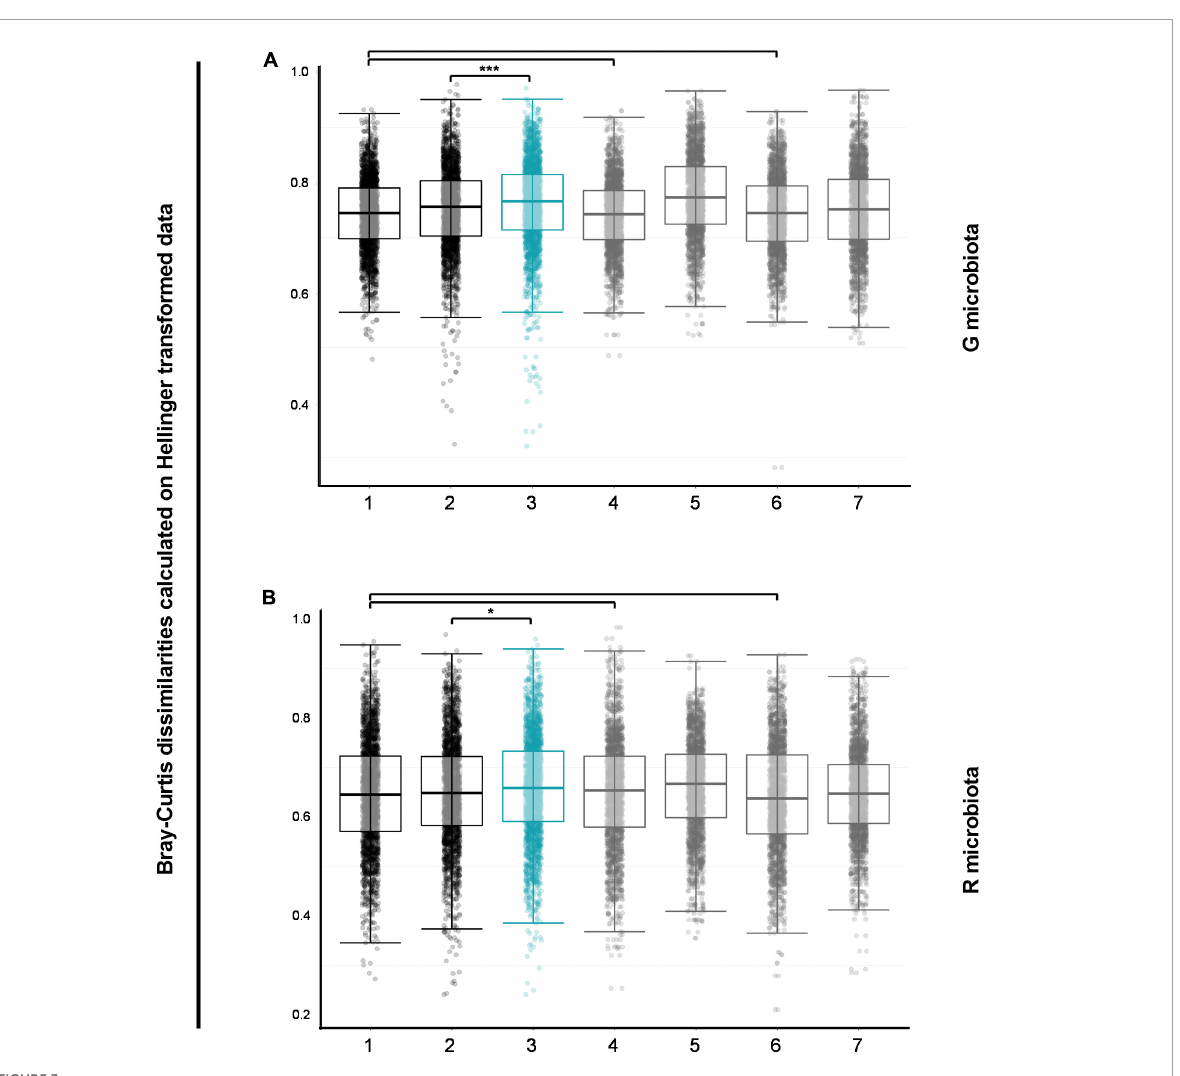
FIGURE3 Pairwise comparisons of Bray–Curtis dissimilarities for G and R microbial communities. Bacterial communities in G (A) and R (B) microbiotas in both groups at enrollment (first black boxes) were similar to bacterial communities within the two groups at enrollment (first and third gray boxes). Control group was used as a reference for changes in oral polio vaccine (OPV) revaccinated over time and bacterial communities in G (A) and R (B) microbiotas changed significantly more over time in OPV revaccinated than in Control group (blue boxes versus second black boxes, respectively, p adjusted < 0.001 for G microbiota and * p adjusted = 0.018 for R microbiota). * p < 0.05; ** p < 0.01; *** p < 0.001; the absence of asterisks for any comparisons indicates that there are no significant differences. Pairwise Wilcoxon rank sum test with continuity correction and p -values adjusted with Benjamini–Hochberg correction for pairwise comparisons of within- and between-group Bray–Curtis dissimilarities of all group-time point combinations. 1—OPV revaccinated Enrollment vs. Control Enrollment ; 2—Control Enrollment vs. Control Follow − up ; 3—OPV revaccinated Enrollment vs. OPV revaccinated Follow − up ; 4—Whithin OPV revaccinated Enrollment ; 5—Whithin OPV revaccinated Follow − up ; 6—Whithin Control Enrollment ; 7—Whithin Control Follow − up